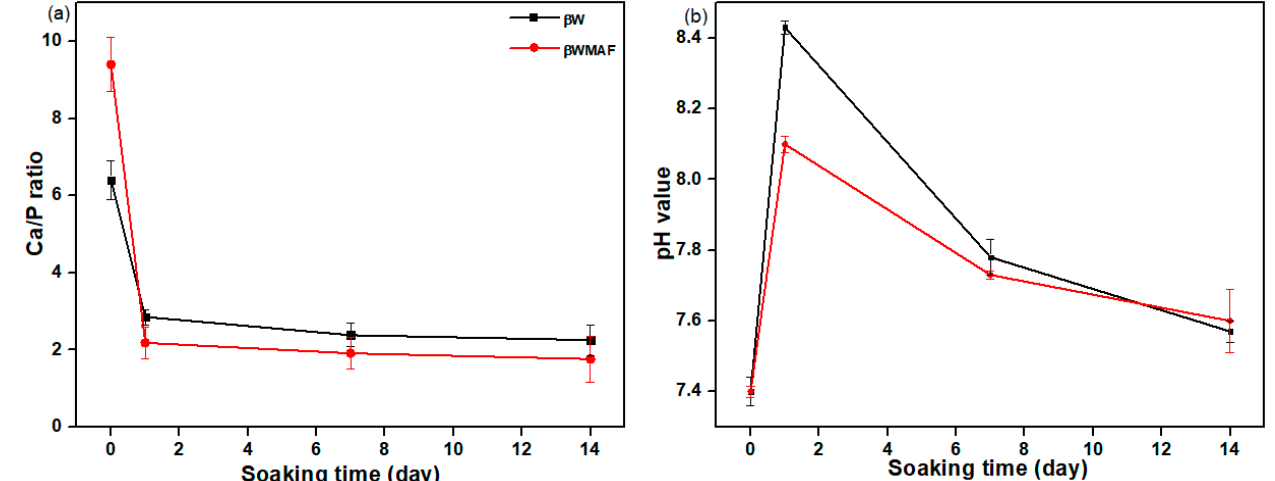
Figure 7. The ( a ) Ca/P ratio and ( b ) pH value of β W and β WMAF disc sample before and after soaking in the SBF up to 14 days.